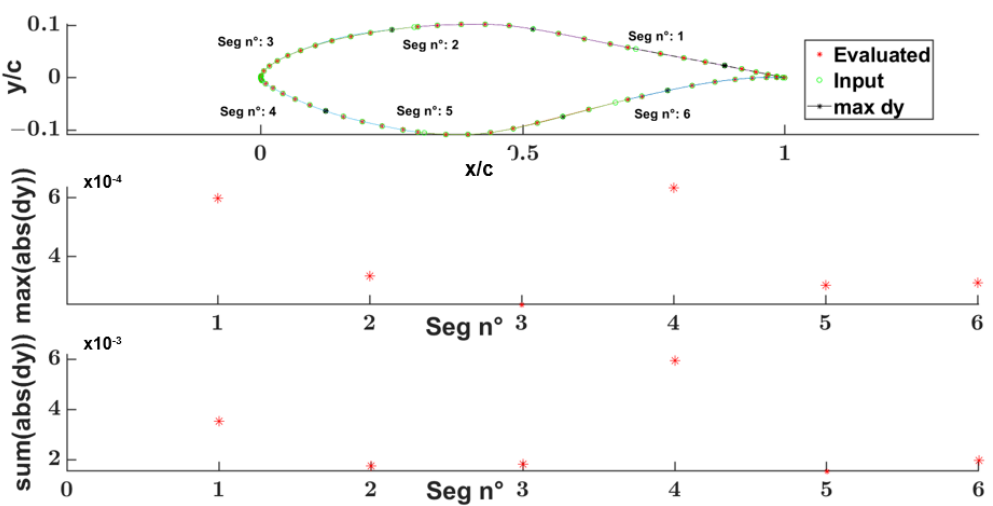
Figure 24. NREL ’ s 809 input and evaluated maximum Euclidean point distance. Figure 25 shows the comparison of the aerodynamic curves 𝑐 (𝛼), 𝑐 (𝑐 ) 𝑐 (𝑐 ), 𝐸(𝛼) = 𝑐 (𝛼) 𝑐 𝑙 𝑙 𝑑 𝑚 𝑙 𝑙 𝑑 (𝛼)⁄ between the target NREL ’ s 809 and parametrized airfoil.